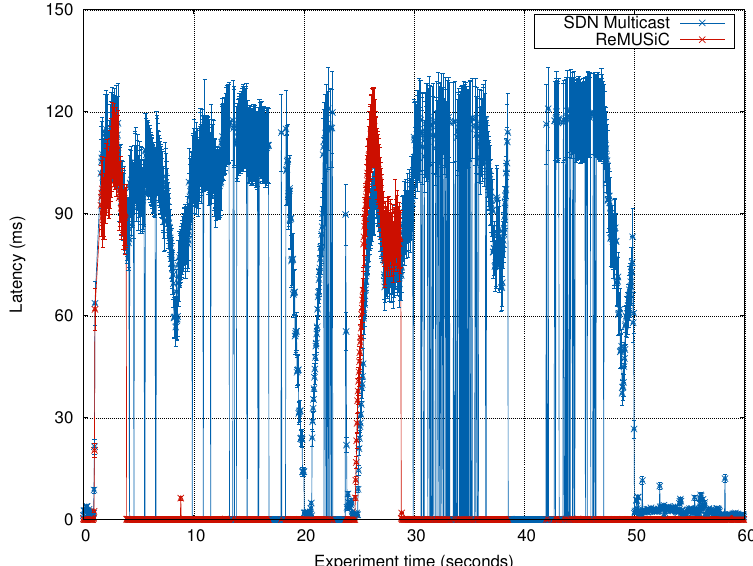
Figure 12. Latency impact in both ReMUSiC and SDN Multicast